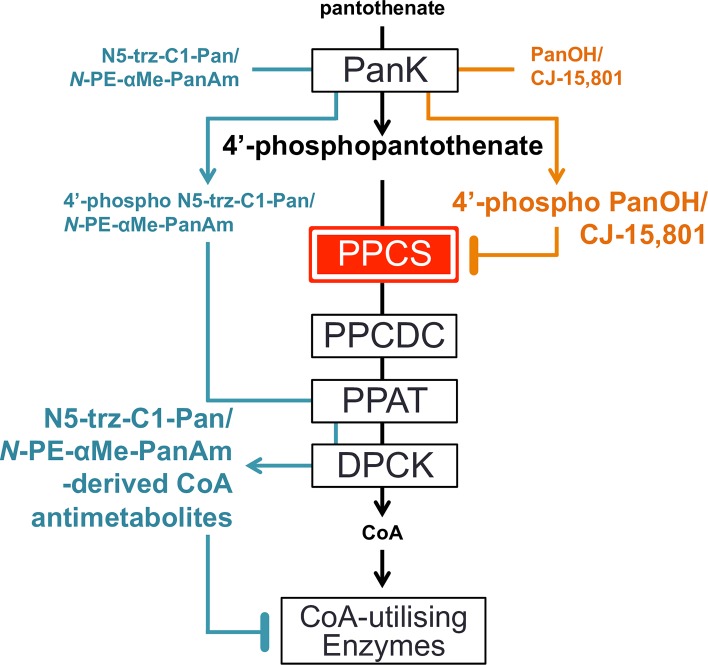
The proposed antiplasmodial mechanisms of action of various pantothenate analogues in Plasmodium falciparum.PanOH and CJ-15,801 (orange) are phosphorylated by PfPanK and their phosphorylated forms accumulate (indicated by the bigger font) and then competitively inhibit PfPPCS. The step mediated by PfPPCS has been hypothesised to be a pathway flux control point (illustrated by the red box) in the CoA biosynthesis pathway. On the other hand, we propose that although N-PE-αMe-PanAm and N5-trz-C1-Pan (cyan) are also phosphorylated by PfPanK, they then bypass PfPPCS and PfPPCDC (as shown previously in bacteria) and rejoin the pathway as substrates of PfPPAT and then PfDPCK, resulting in the generation and accumulation of CoA antimetabolites. These CoA antimetabolites exert their antiplasmodial activity by inhibiting CoA-dependent processes.